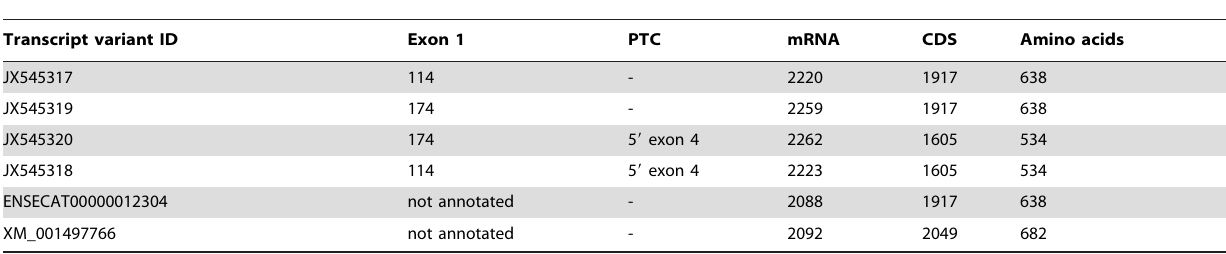
Table 1. Transcript variants detected in the equine PLCz1 .